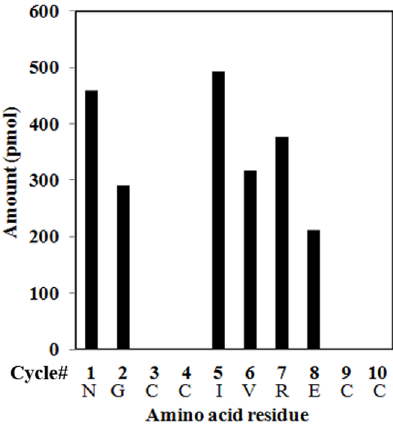
-C IAA-labeled Bn5a and (B) C 1 4